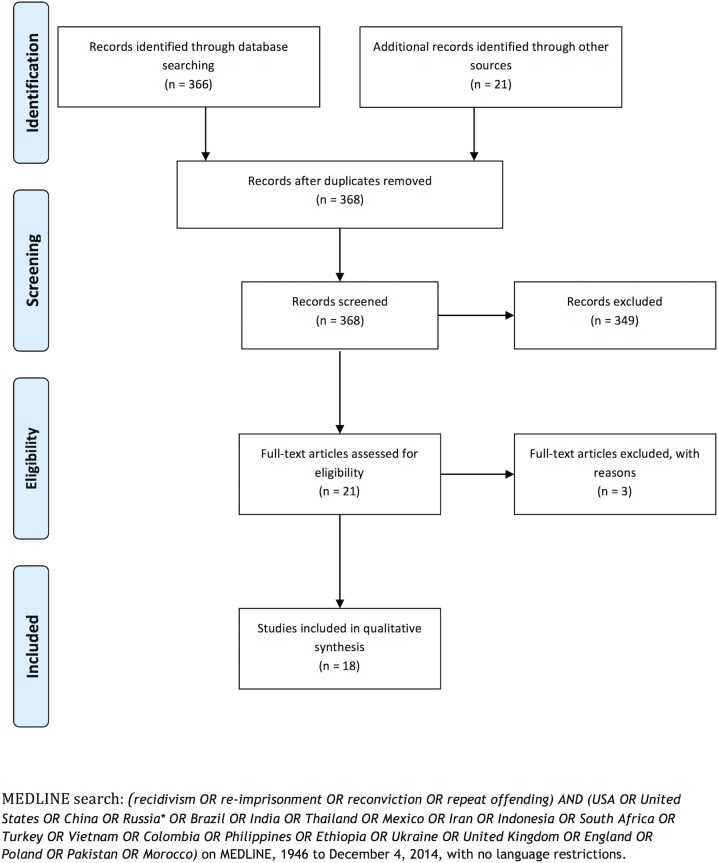
PRISMA Flow Diagram.